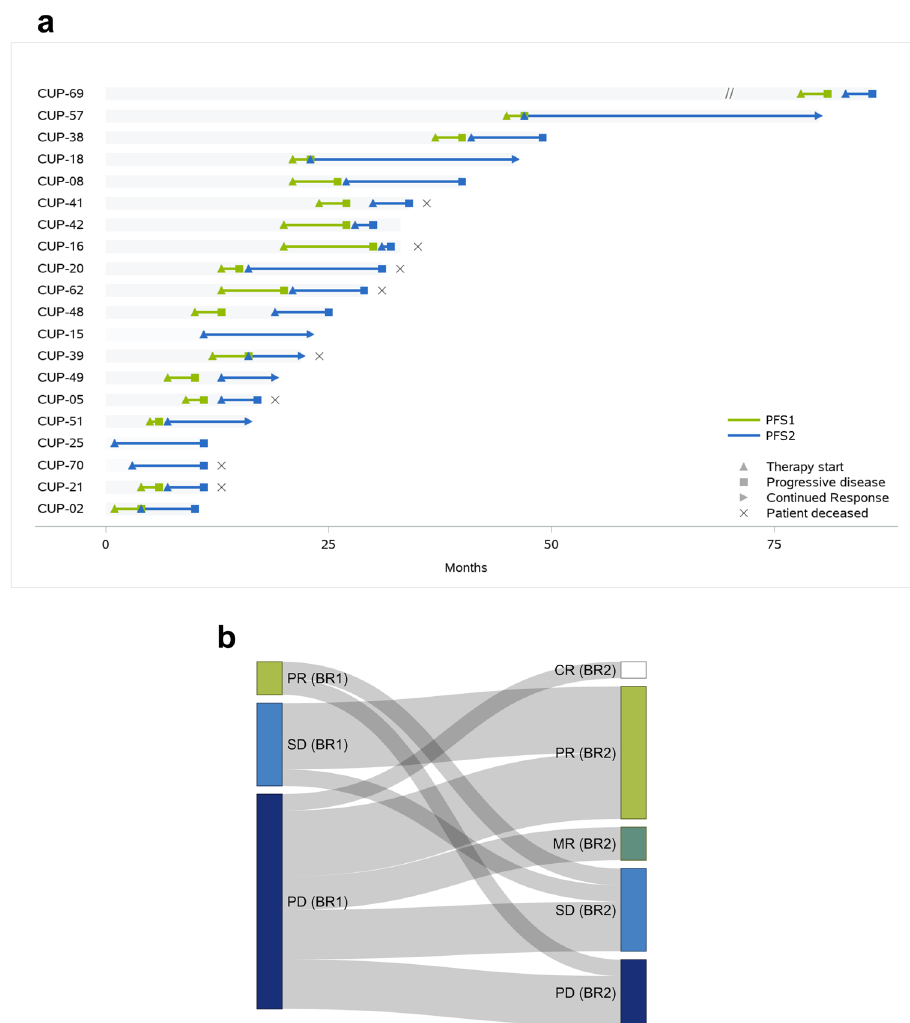
Fig. 5 Clinical course of 20 patients with molecularly guided therapy. a Each bar represents one patient in the study starting from date of diagnosis. PFS of the last systemic therapy before molecular analysis (PFS1, green) and the fi rst applied molecularly guided therapy (PFS2, blue) are plotted inside those bars. Continued response at the end of the observation period is marked with an arrow. The CUP-69 bar has been shortened by 60 months for visibility (true length 146 months). For CUP-15, CUP-25 and CUP-70 neither PFSr nor mPFSr could be calculated. b Sankey plot depicting best response associated with the last systemic therapy before genomic and transcriptomic analysis (BR1, n = 20) in comparison with best response associated with the fi rst applied molecularly guided therapy (BR2, n = 20). Source data are provided as a Source Data fi